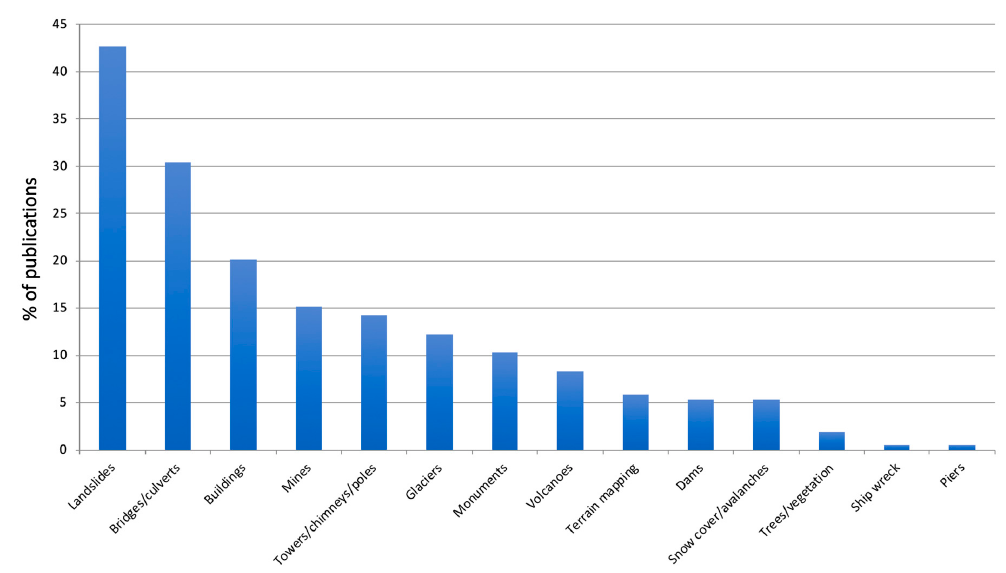
Figure 6. Papers published until December 2018 classified on the basis of the operative band.